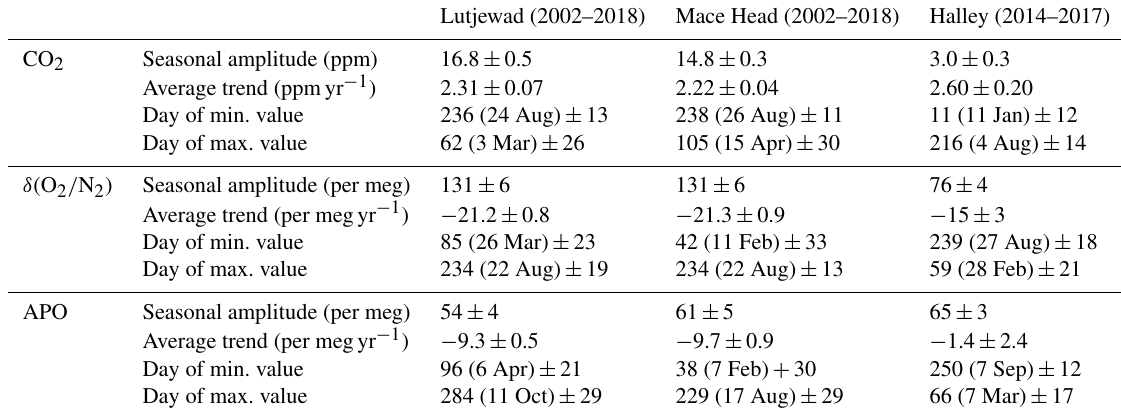
Table 4. Trends and seasonality fit parameters of the measurement records from all three stations, as presented in Figs.